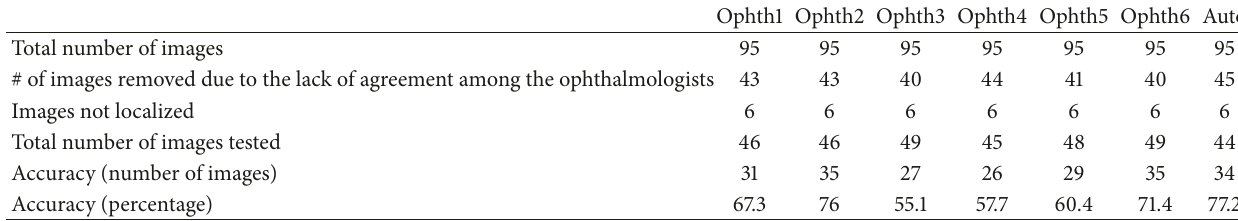
Table 13: The final results for Magrabi images set.